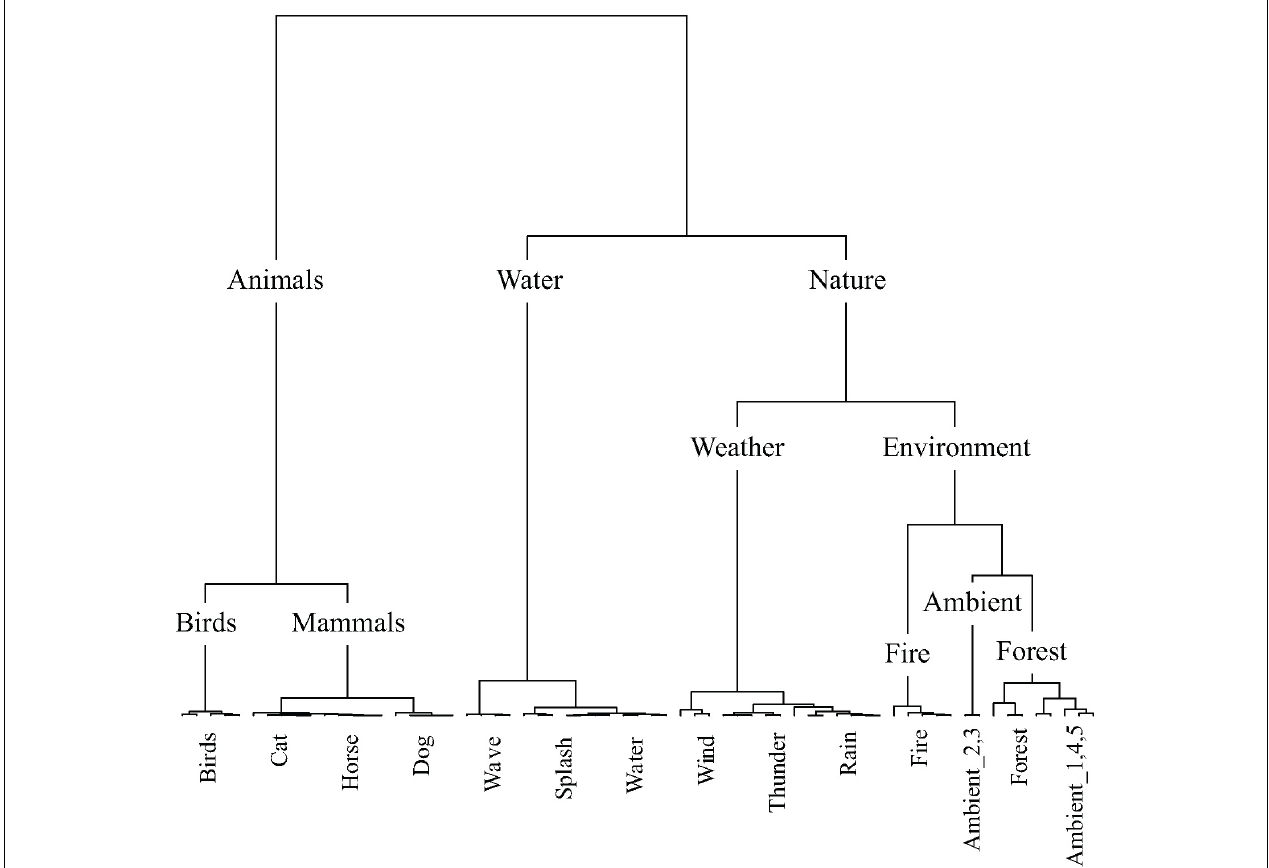
FIGURE 7 | The nature taxonomy generated by hierarchical cluster analysis of the principal dimensions resulting from correspondence analysis. Note that five exemplars of each sound were used in this study. All five exemplars of each sound were categorized together, except for the case of ambient where two exemplars were categorized together in a category by the same name and three were categorized as forest